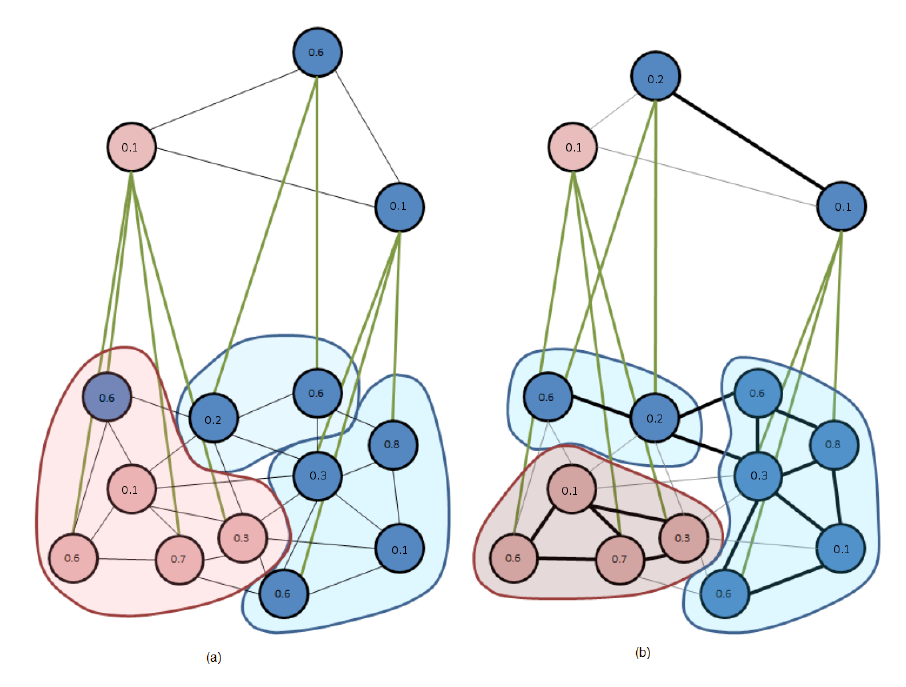
Figure 11. Influence of the thresholding of intra-level edges within the internal structure of the data-driven decimation process (D3P) algorithm: ( a ) The original D3P; and ( b ) The bounded D3P (BD3P) (see the text for